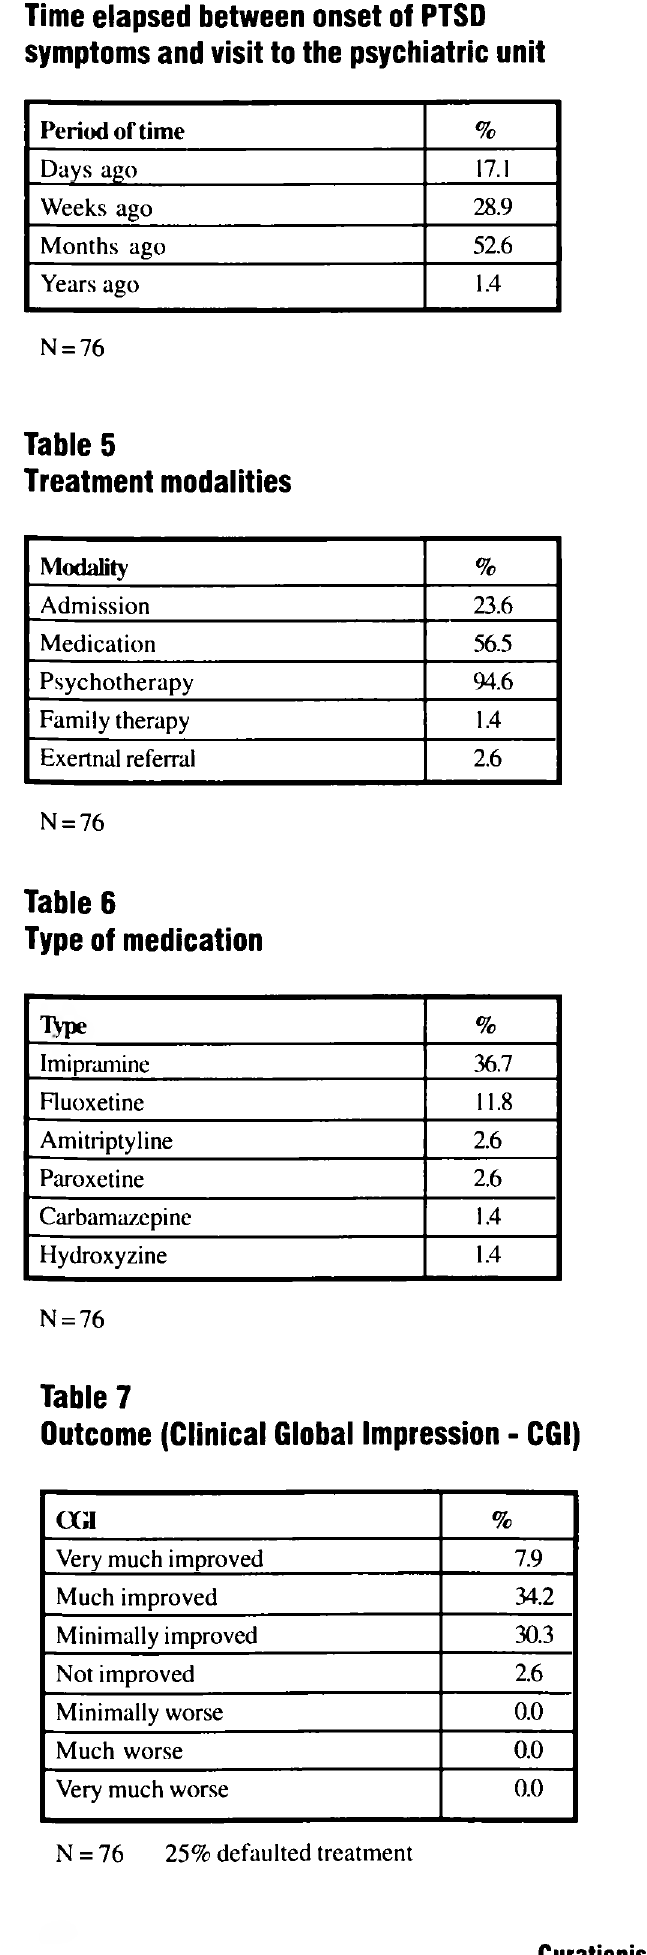
symptoms and visit to the psychiatric unit